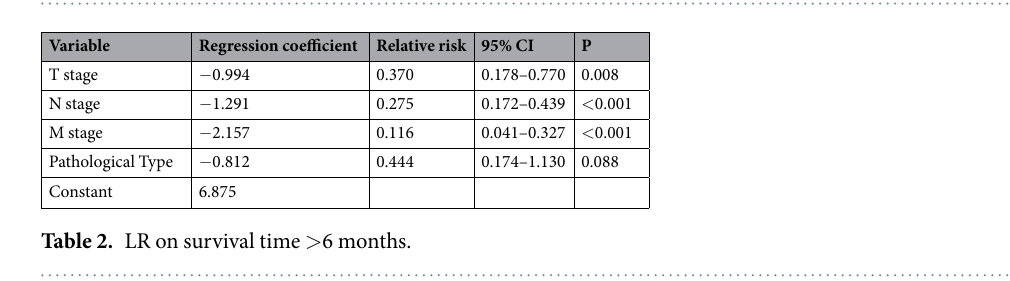
Table 1. Confusion matrix and reliability and accuracy of the BN model of prognosis.